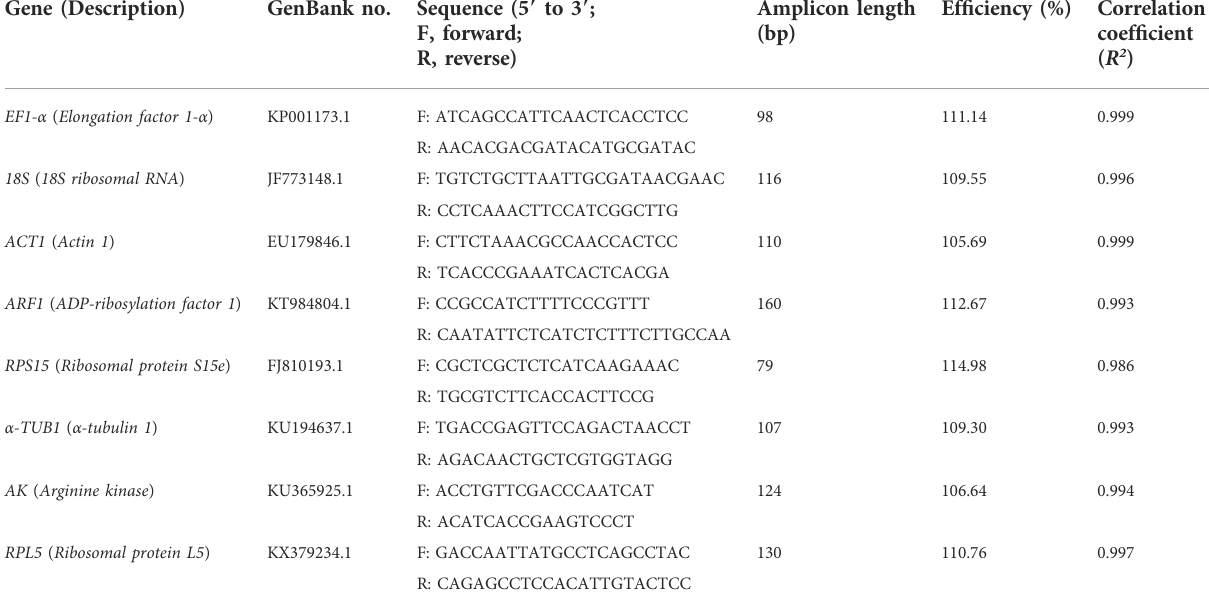
TABLE 1 Primers and amplicon characteristics of the eight candidate reference